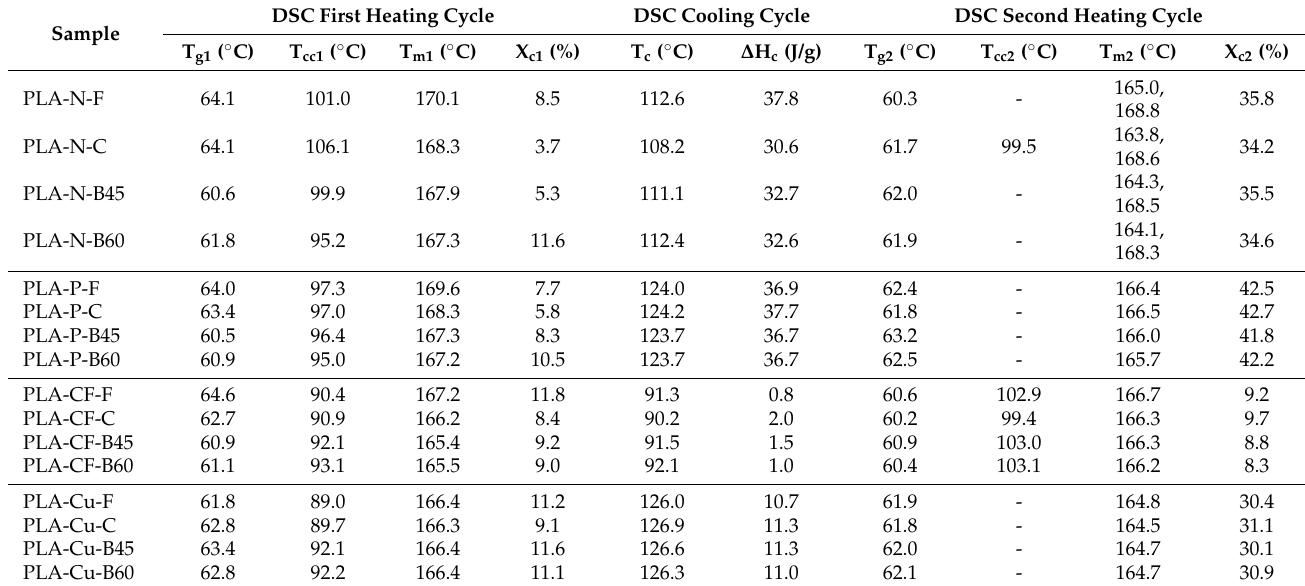
Table 4. Thermal properties and crystallinity of filaments, compression molded sheets, and 3D printed